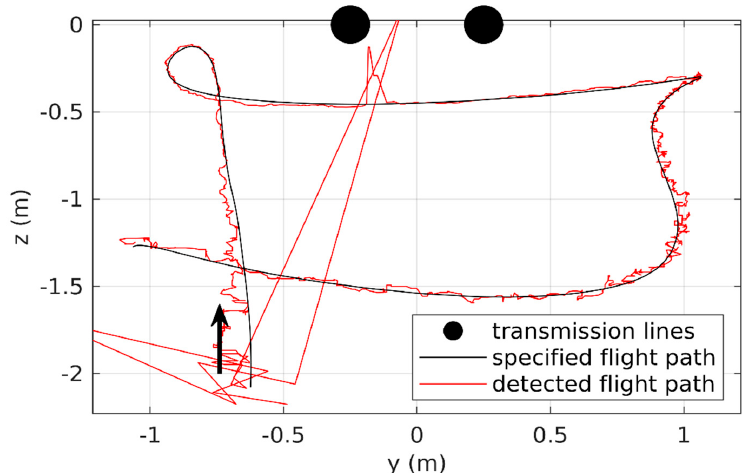
Figure 13. Localization quality, three sensors, σ = 8 μ T.